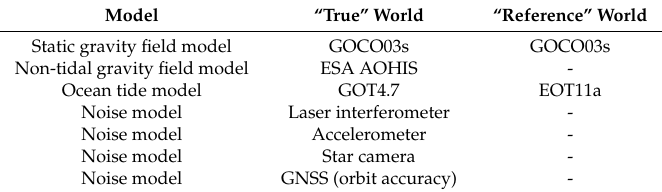
Table 2. Force and noise models of the “true” and “reference” world used in the